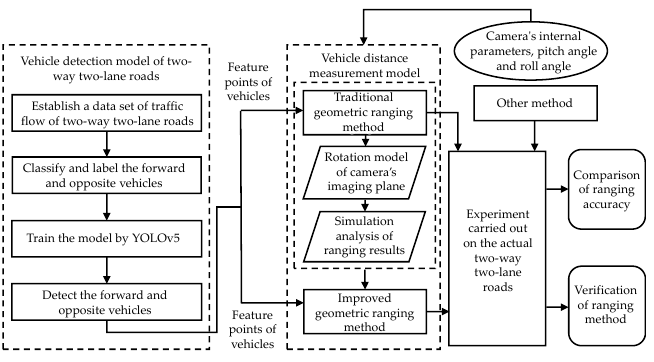
Figure 1. Overall framework of the method.